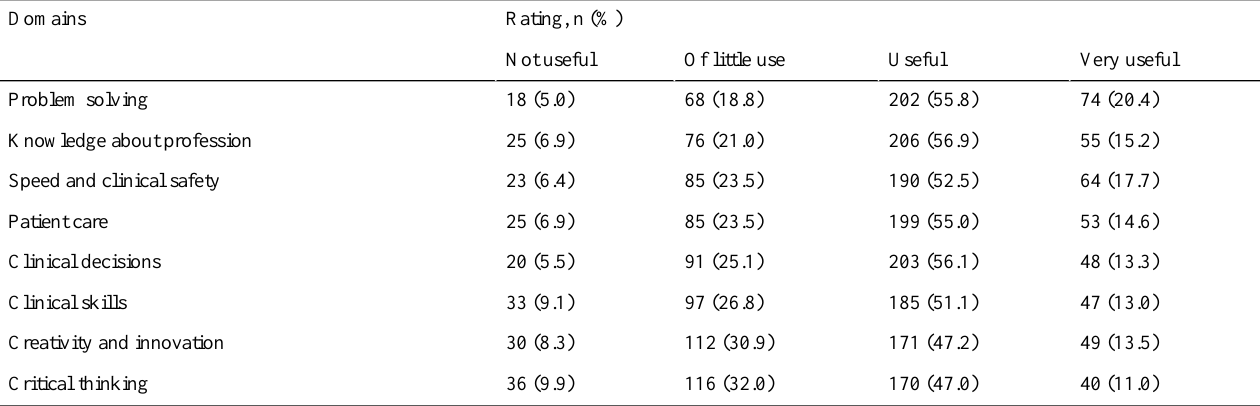
Table 3. Assessment of the usefulness of social networking sites in the 8 domains analyzed (n=362).